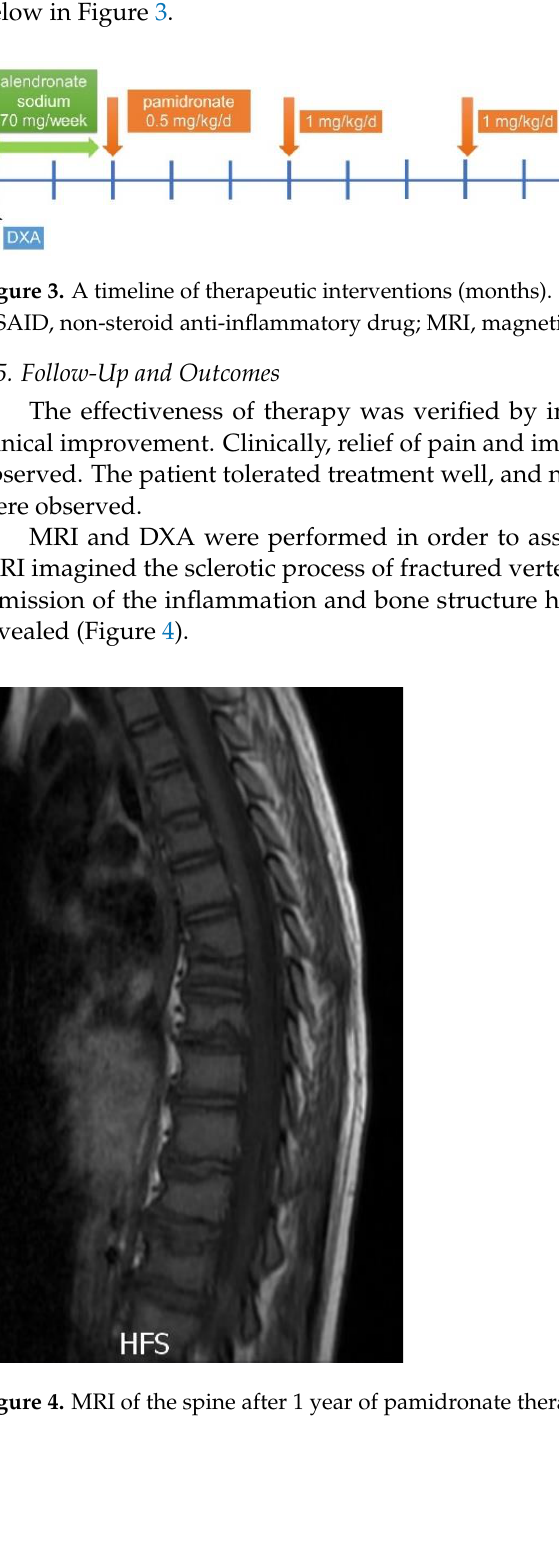
Table 2. Summary of patient’s course of tre atment. Date of Hospitalization (Cycle) Weight in kg (Centile) Height in cm (Centile)